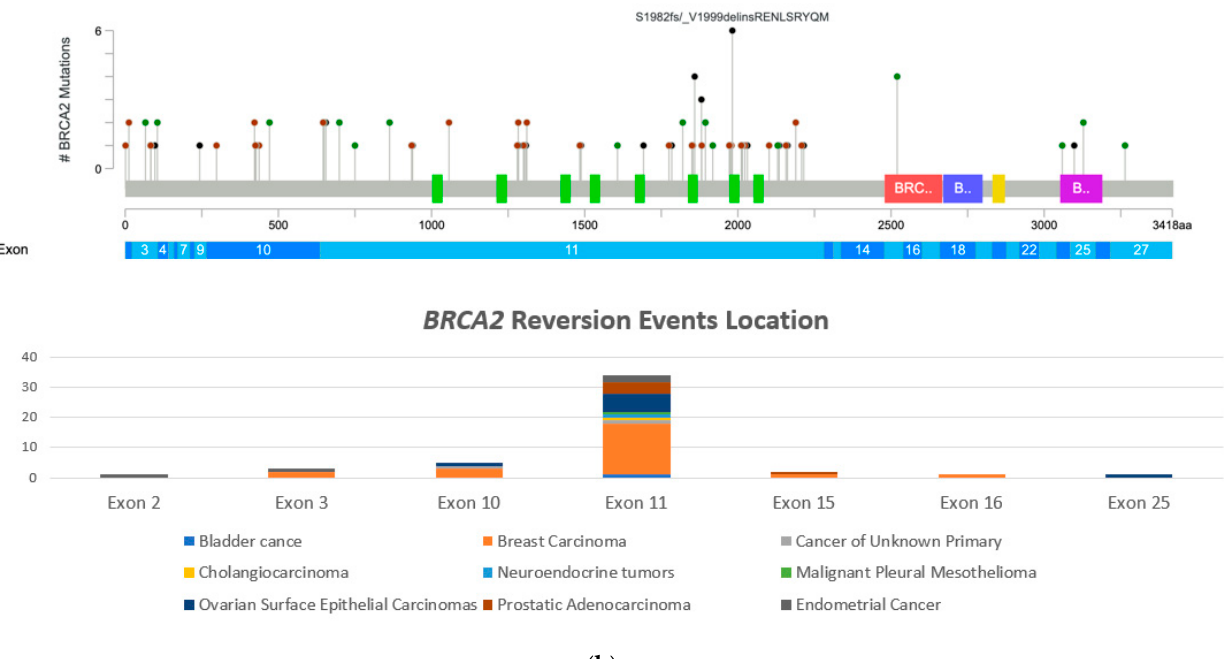
Figure 1. Lollipop plot of reported reversion mutations. ( a ) Reversion mutations in BRCA1 gene with corresponding affected exons and by tumor type. ( b ) BRCA2 reversion mutations with corre- sponding affected exons by tumor type (MutationMapper by cBioPortal: https://www.cbioportal.org/mutation_mapper, accessed on 7 November, 2022).